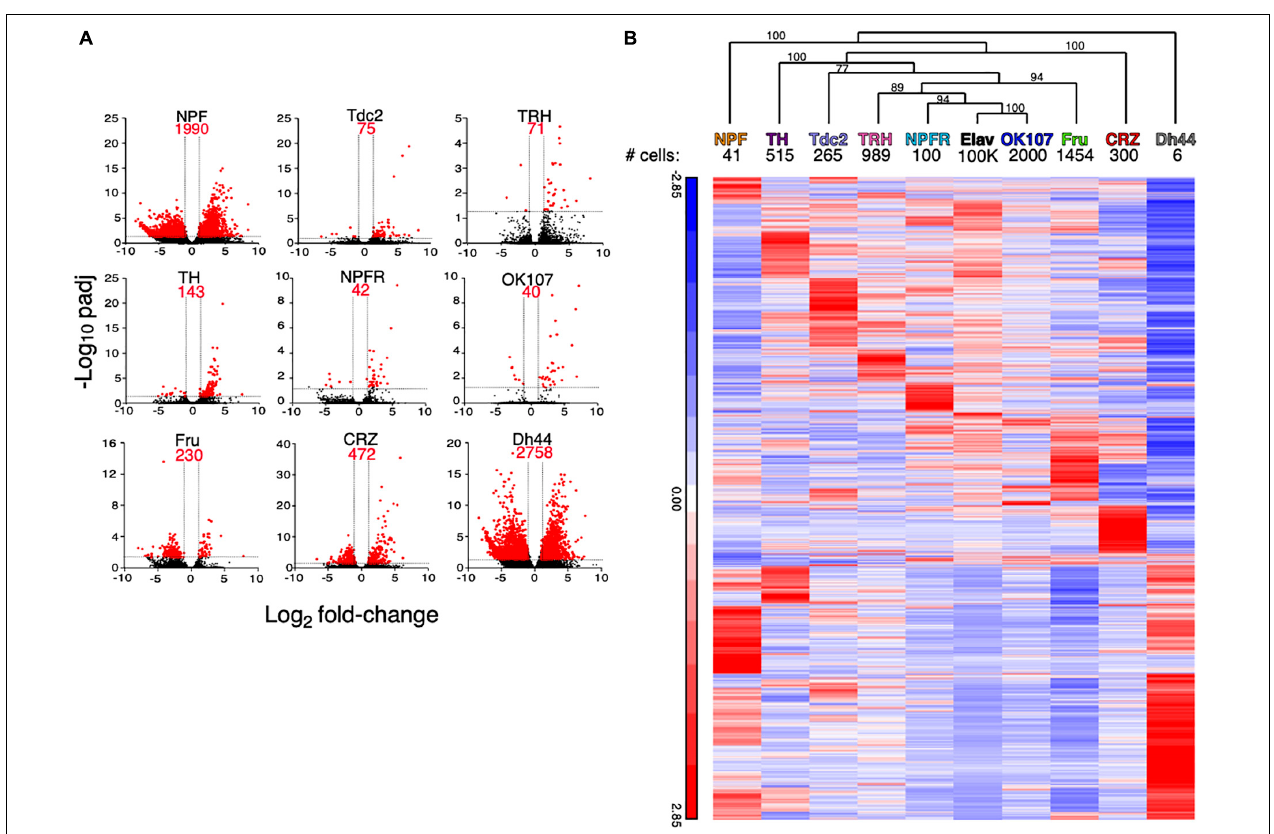
FIGURE 1 | Different neuronal populations exhibit varying number of differentially expressed genes when compared to the general population of neurons. (A) Volcano plots of log 2 average fold change per population of all genes (black) and significantly expressed genes (red) compared to ElaV. Dashed lines indicate thresholds for fold change and adjusted p -values. (B) Hierarchical clustering of average normalized reads for all significantly expressed genes in 9 neuronal populations compared to a pan neuronal driver (ElaV). Clustering analysis was performed using Partek. Hierarchical clustering dendrogram with p -values. Values on the edges of the clustering are AU (Approximately Unbiased) p -values. Clusters with AU ≥ 95% are considered to be strongly supported by